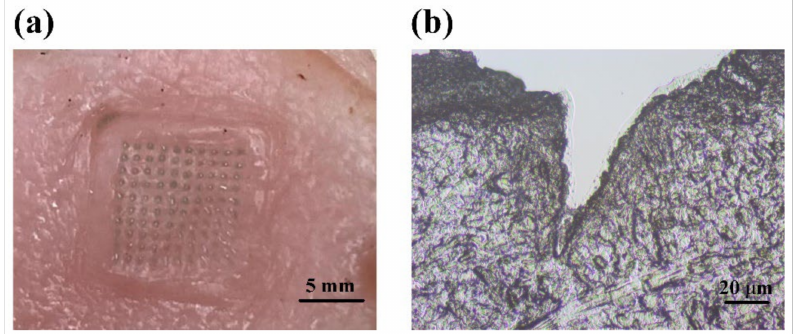
Figure 2. ( a ) Photography of MNs punctured porcine skin. ( b ) Histological slice of the porcine skin along the cross-section in the punctured site, showing the trace of microneedle insertion into the tissue